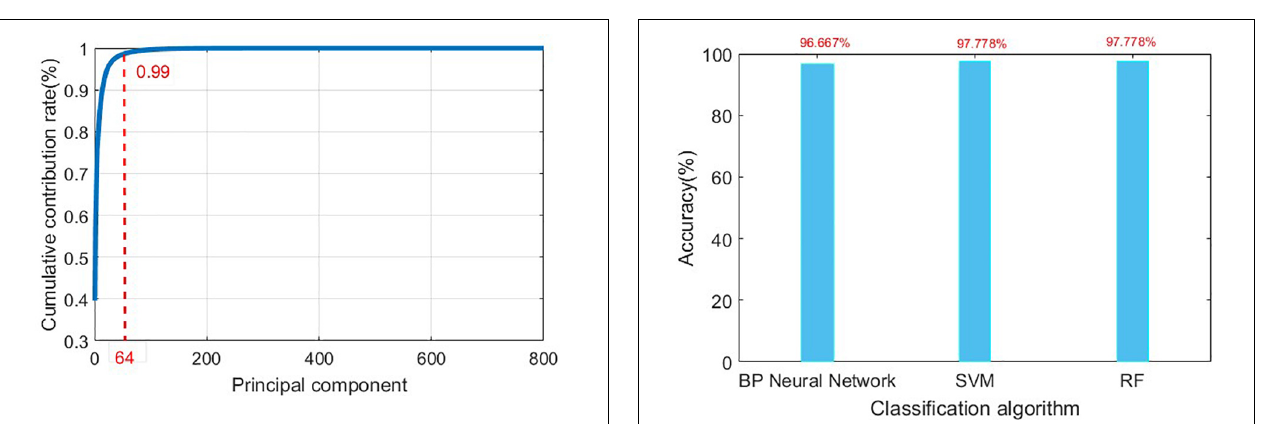
FIGURE 11 | Principal component cumulative contribution rate curve. TABLE 3 | Confusion matrix for Romberg’s test.